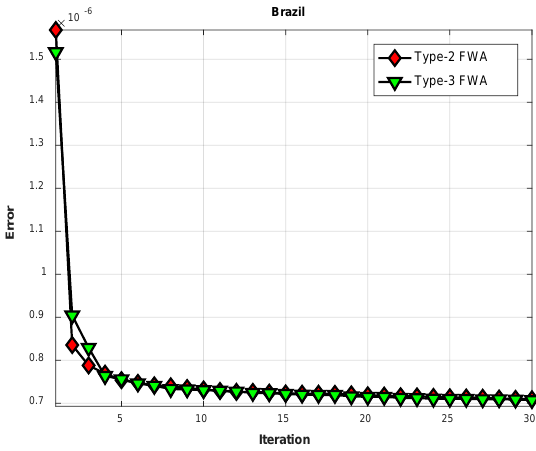
Figure 13. Type-3 fuzzy input variables (Brazil): ( a ) fuzzy input #1; ( b ) fuzzy input #2; ( c ) fuzzy input #3.